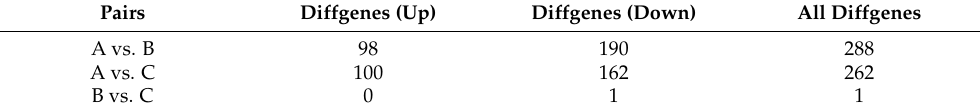
Table 2. Statistics of differentially expressed lncRNAs in submandibular glands of goats at different ages. Pairs